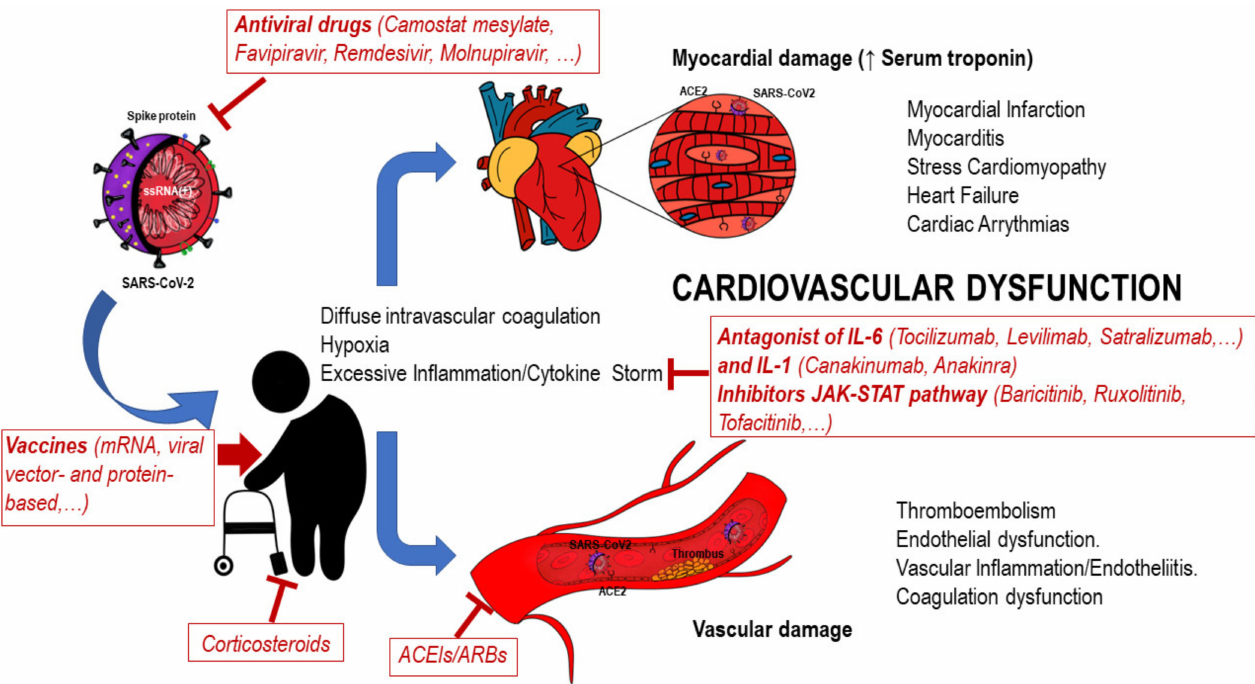
Figure 1. Impact of SARS-CoV-2 infection on cardiovascular system in older adults. Entry of SARS- CoV-2 into host cells (ciliated nasal epithelium; cardiomyocytes and endothelial cells) is mediated by angiotensin-converting enzyme 2 (ACE2) receptor. Main cardiovascular clinical alterations include myocardial injury, myocarditis, acute coronary syndrome, cardiac arrhythmia and thromboembolism. Elevation of D-dimers or prothrombin time, factors involved in blood clotting, are hallmarks of SARS-CoV-2 virus infection. Therapies against SARS-CoV-2 are